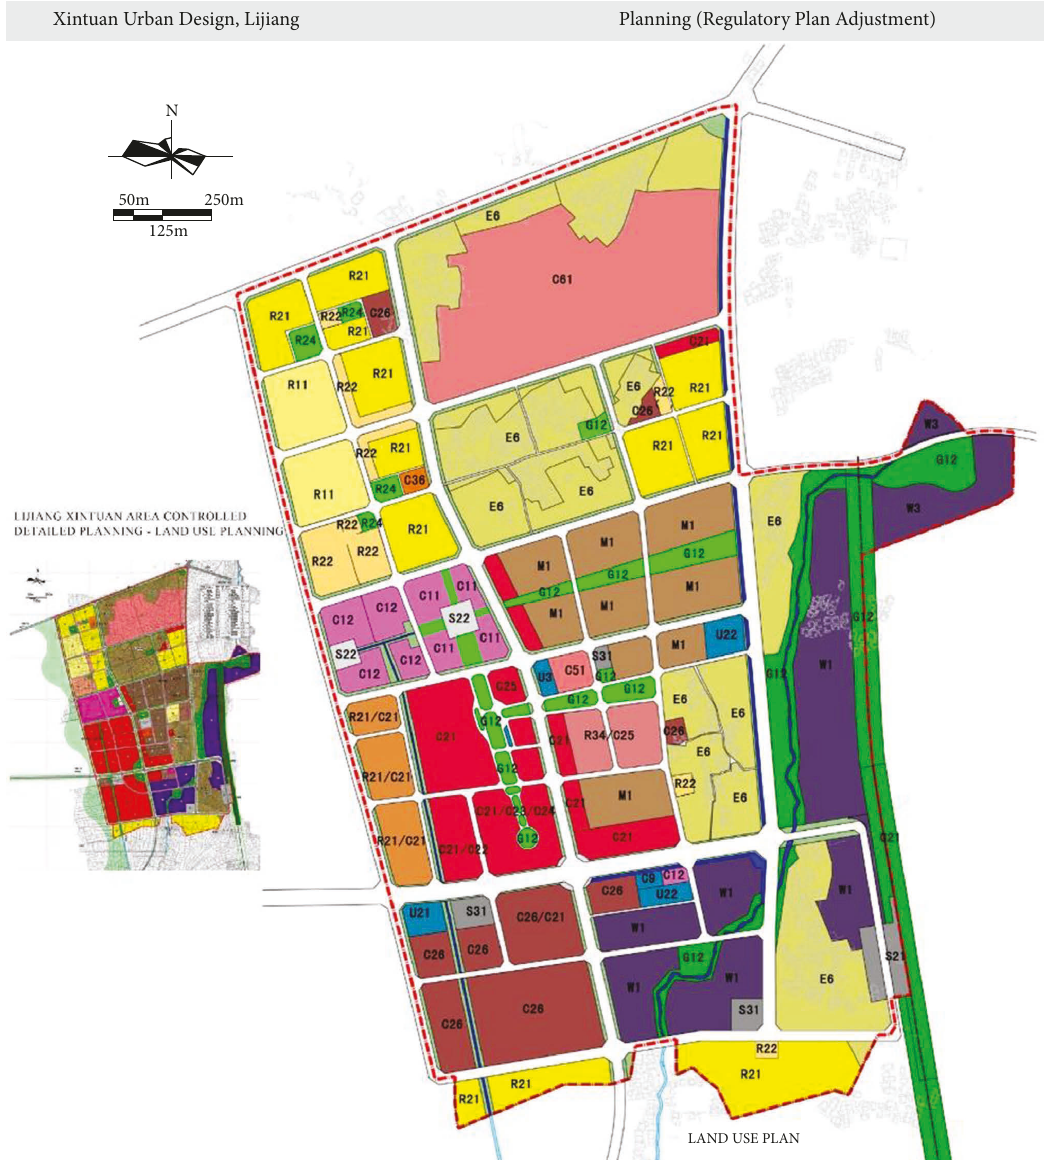
Figure 6: Schematic diagram of site planning.